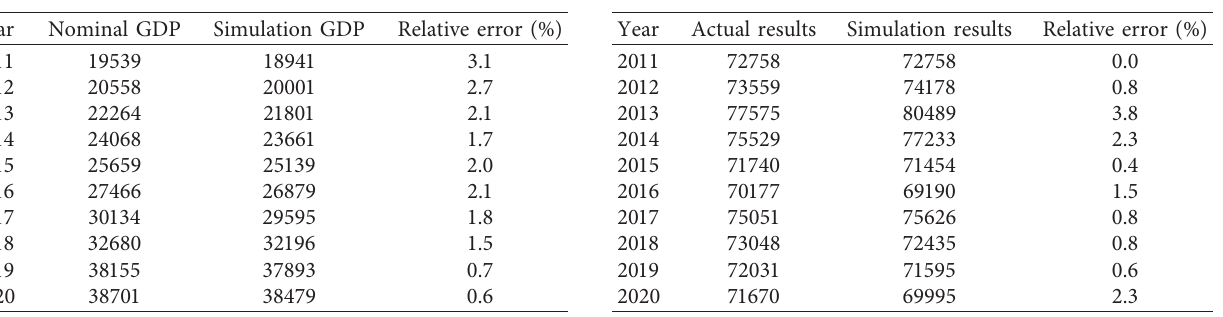
Table function form, for instance: real GDP growth rate � ([(2011,0)-(2022,0.09)], (2011,0.075), (2012,0.079), (2013,0.071),